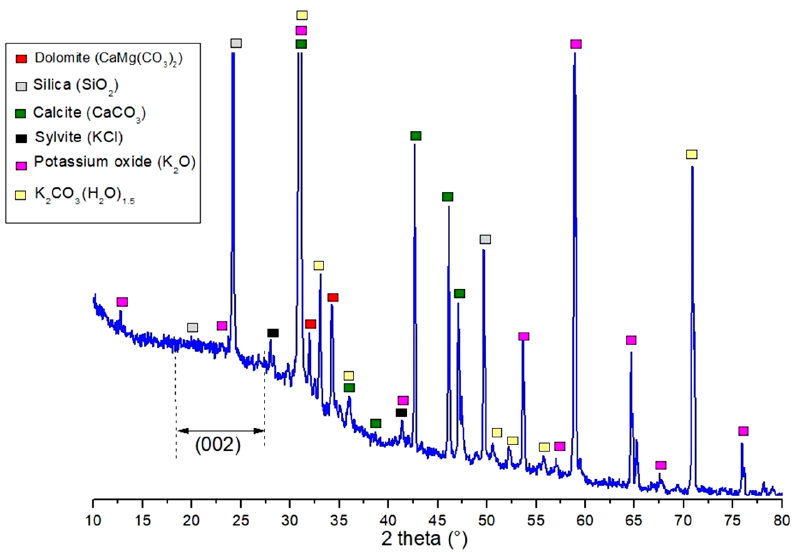
Figure 4. XRD patterns of the EOP biochar.